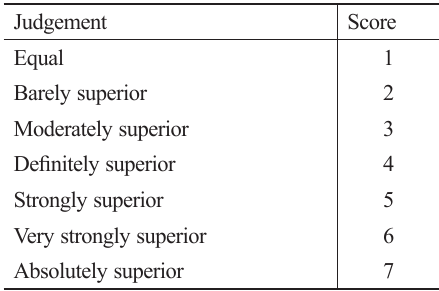
Table 2. AHP judgement scale